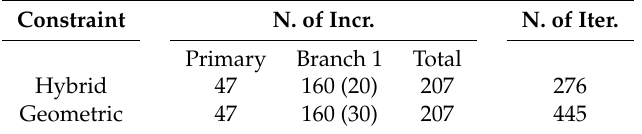
Table 2. Number of increments using different constraint equations. (˜ τ in the parenthesis).